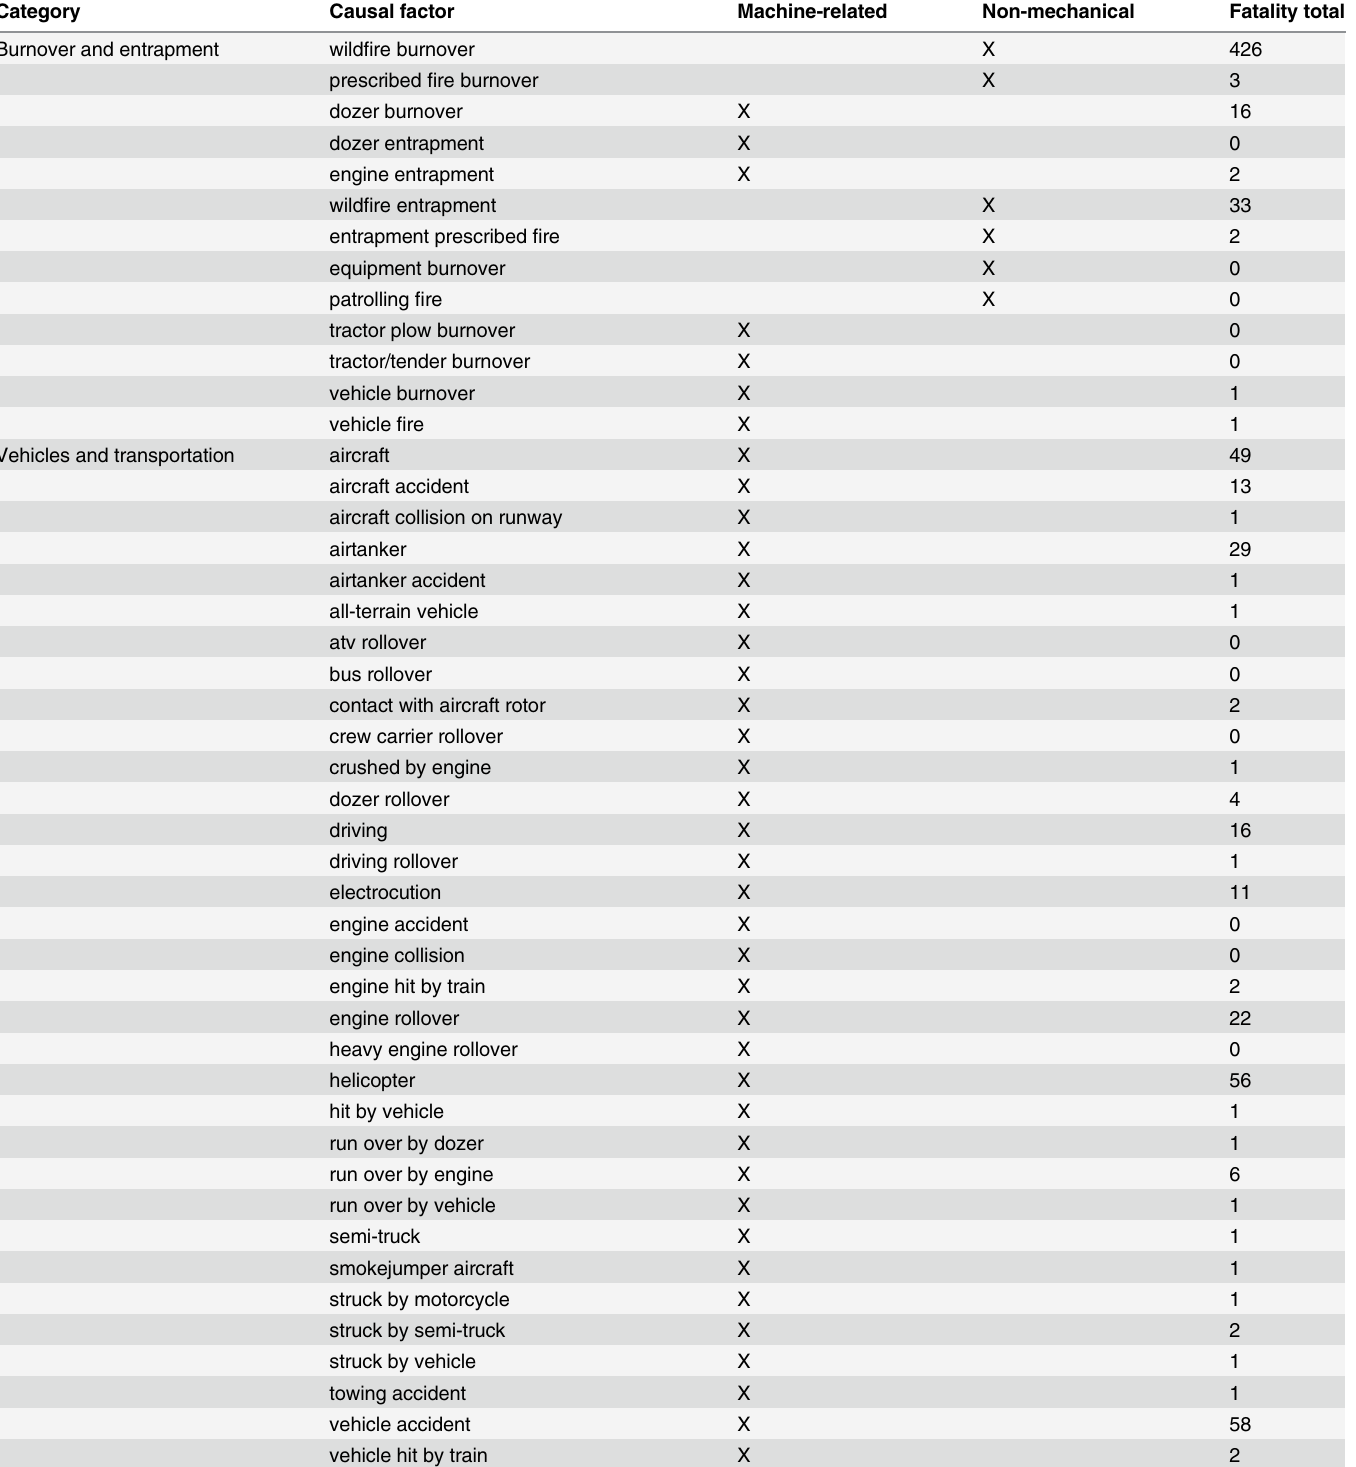
Table 3. Machine-related and non-mechanical causes of wildland fire-related fatalities based on our classification scheme used to summarize the Wildland Fire Accidents Database.